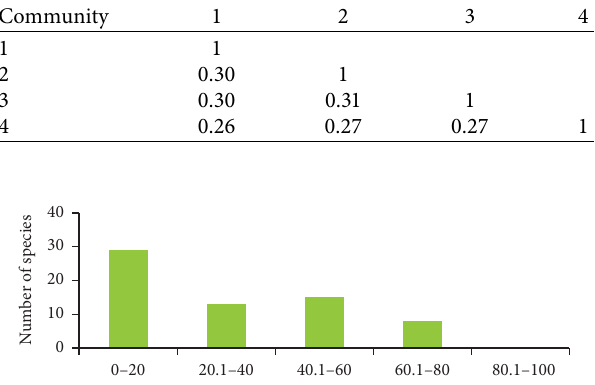
Table 4: Jaccard’s similarity coefcient between four plant communities.